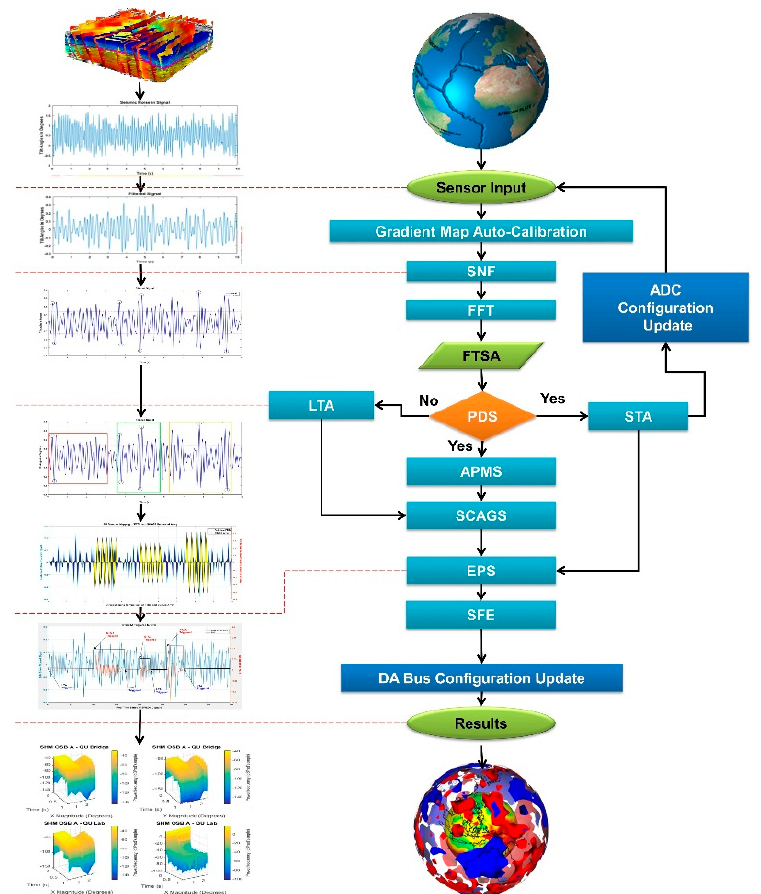
Figure 2. Seismic wave event detection algorithm (SWEDA) process flow diagram.